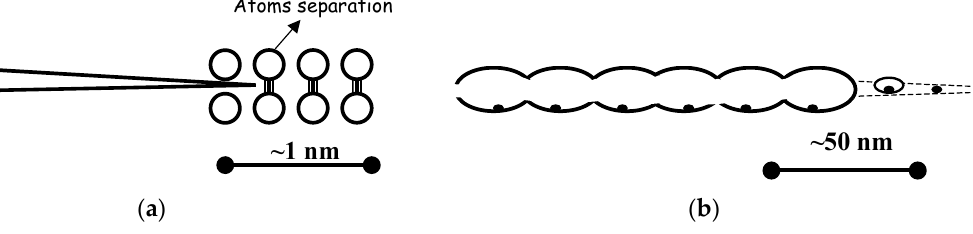
Figure 1. Schematic types of macro brittle intergranular fracture according [3]: ( a ) Atomically brittle intergranular fracture—featureless facets observed for high resolution SEM or TEM replicas often associated with embrittling segregation; ( b ) Nano-scale dimpled intergranular fracture—very shallow dimples—sometimes not resolved by SEM: can occur due to the micro void coalescence (MVC) process in the very narrow soft zone adjacent to grain boundary.